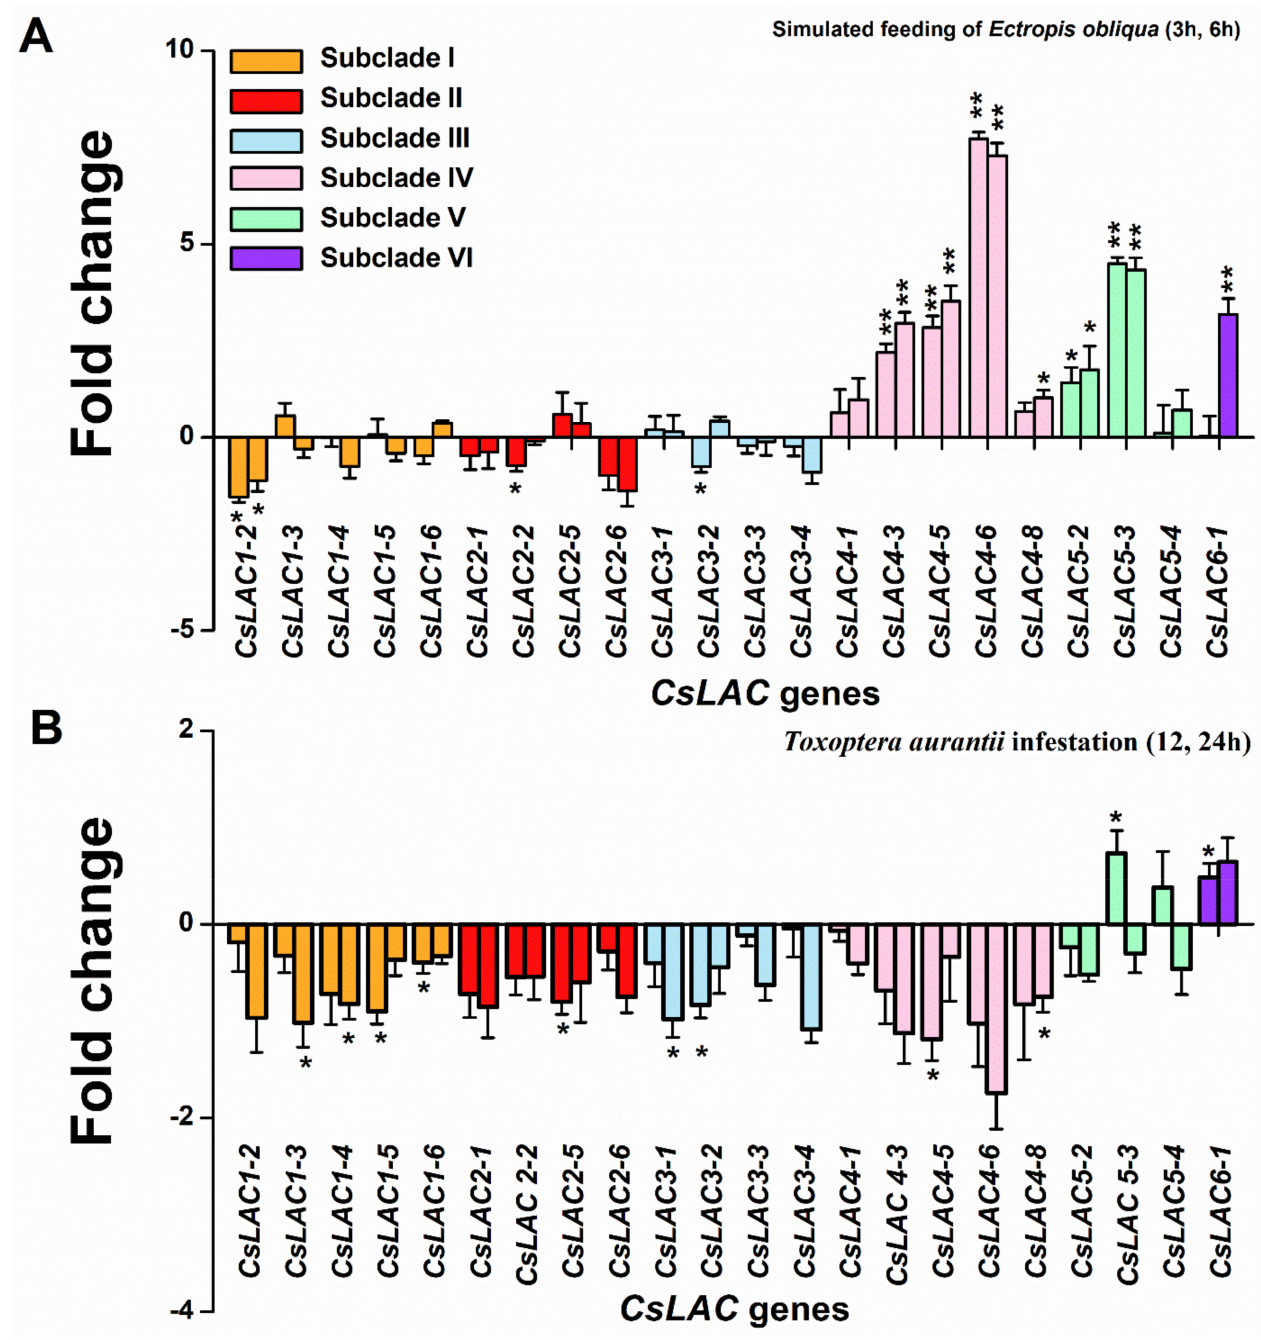
Figure 8. Expression patterns of differentially expressed CsLAC s from C. sinensis cv ‘Longjing43 (cid:48) cultivars upon herbivory infestation. The fold change in expression levels (treated group vs. control group) is shown on a log2 scale. ( A ) The change in expression levels of CsLAC s in response to simulated Ectropis obliqua feeding by RT-qPCR. The left and right bar graphs for each gene represent the fold change after treatment at 3h and 6h, respectively. ( B ) The change in expression levels of CsLAC s in response to Toxoptera aurantii infestation by RT-qPCR. The left and right bar graphs for each gene represent the fold change after treatment at 12h and 24h, respectively. The asterisks above lines indicate significant differences between the herbivore treatment and the control (*, p < 0.05, **, p < 0.01, Student’s t